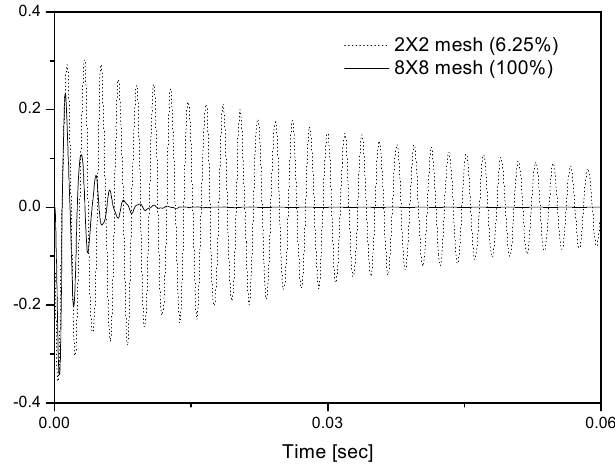
Figure 6. Non-dimensional deflections according to various sizes for the sensor/actuator pairs. Figure 7 shows the effect of positions for piezoelectric materials for the inner layer and outer layer. In the two cases, the piezolayers are placed at the nearest and farthest points from the midplane, respectively. As the layers move farther from the midplane, the more quickly they are suppressed. This is due to the maximum moment generated by the layer, which occurs when the layers are placed farthest from the midplane. That is, the be obtained with respect to the midplane.